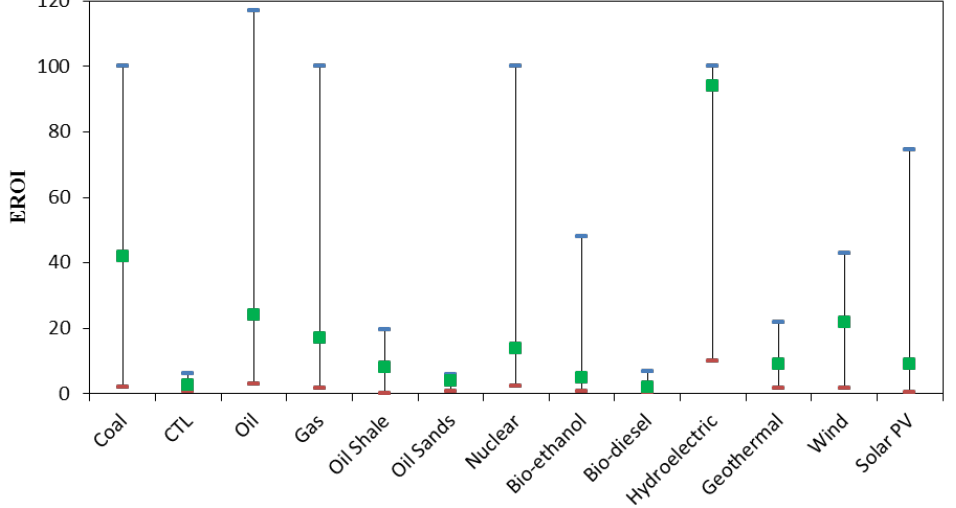
Figure 9. The mean EROI values for various fuel sources from published values. CTL has a mean EROI of approximately 2.6:1 ( n of 19 from 4 publications, including this paper) [7–9]. The mean EROI values for other fuel sources are from